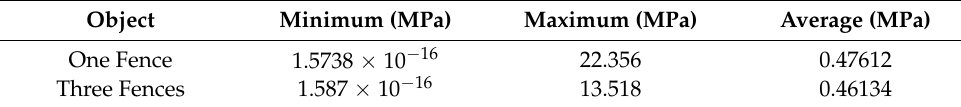
Table 3. Stress Values for Titanium